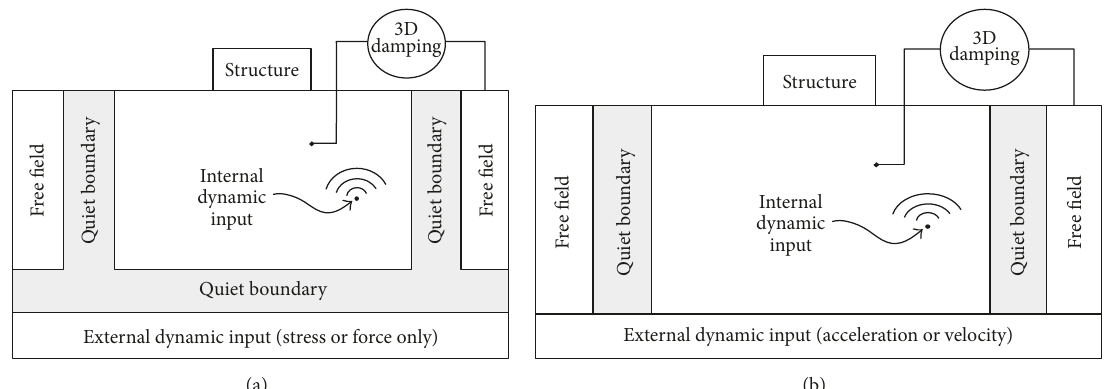
Figure 7: Quiet boundaries for (a) rigid and (b) flexible beds in FLAC 3D [16].